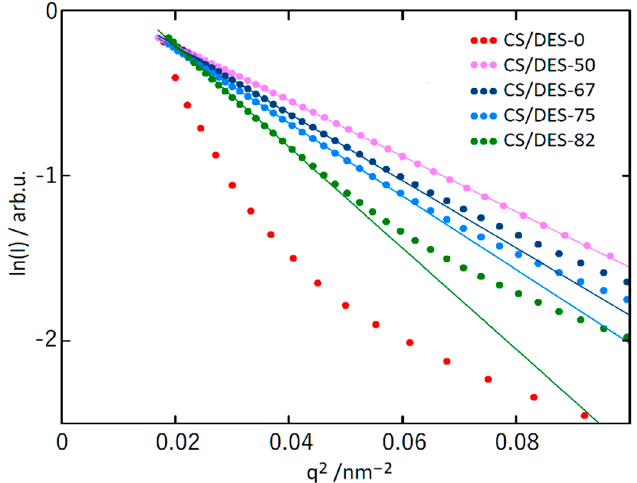
Figure 6. The SAXS patterns for CS-lactic acid film (CS/DES-0) and films with different NADES contents (50, 67, 75 and 82 wt%) in the Guinier coordinates. Straight lines demonstrate the slope of curves at the low q 2 values.